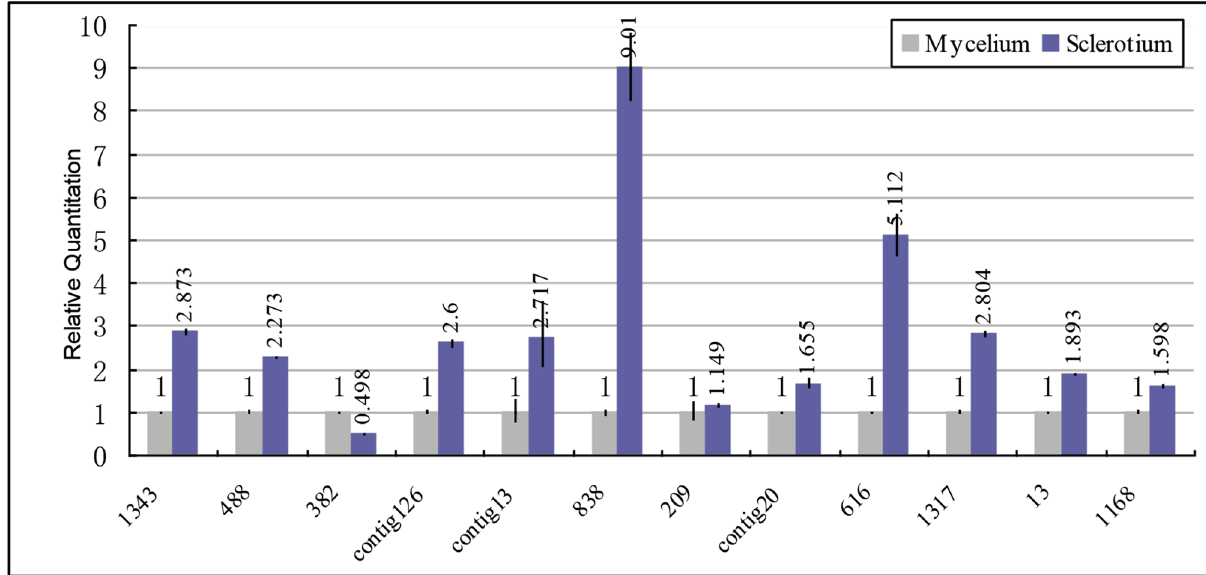
Figure 5. Expression patterns of signal related genes from SSH library using qPCR analyses. Blue columns represent the RQ in sclerotium; light grey columns indicate the RQ in mycelium. All standards are run in duplicate and samples are run in triplicate. Puctg838, Puctg616, Puctg1343, Pu13, Pu1168: small GTPase; Puctg20, Puctg13, Pu1317, Pu382, Pu488: protein kinase; Puctg126: G protein; Pu209: G protein-coupled receptor